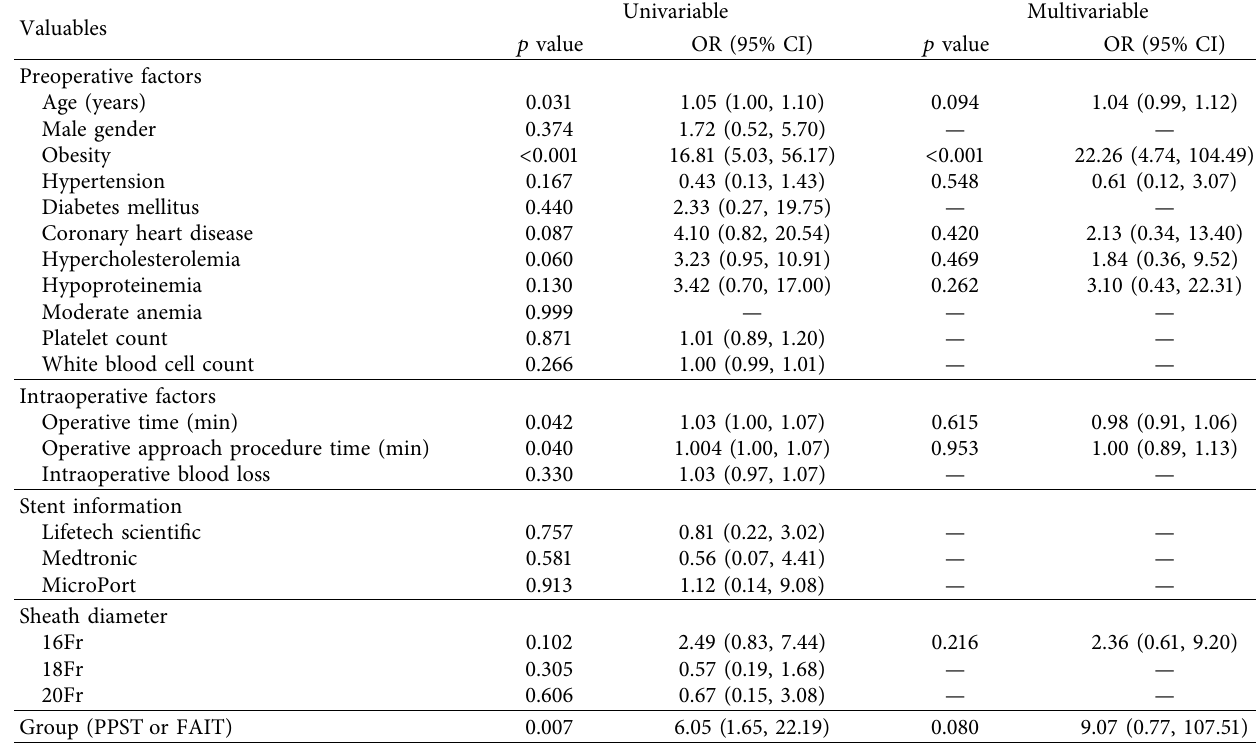
Table 4: Univariable and multivariable logistic regression analysis of risk factors for postoperative approach procedure-related complications.